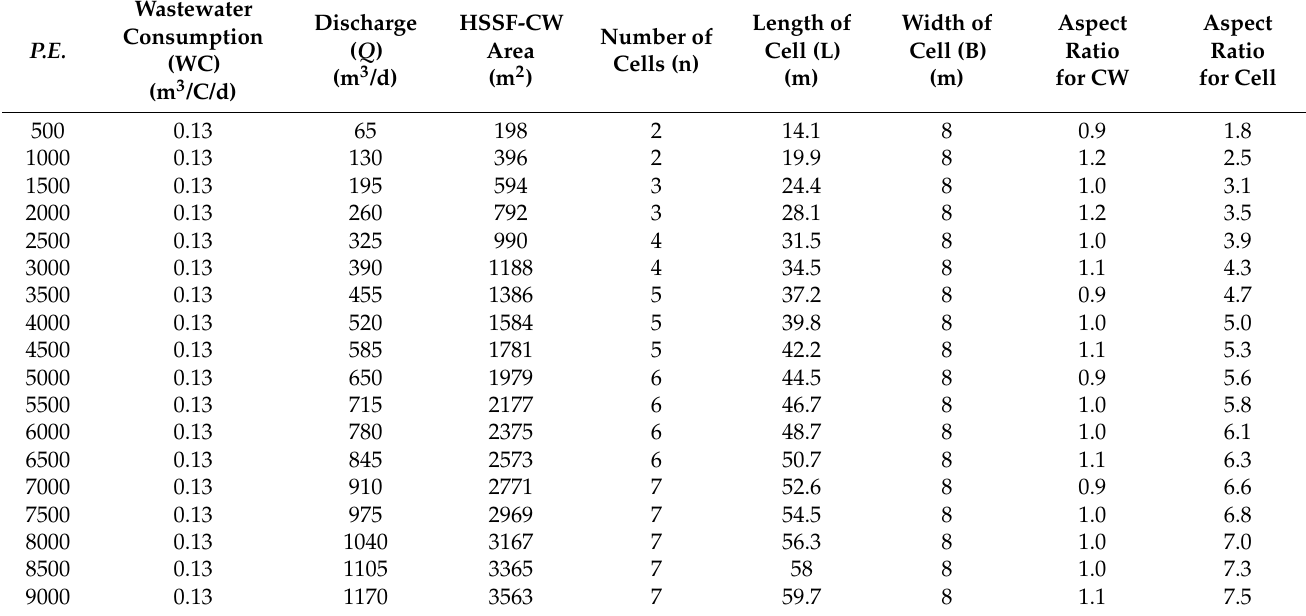
Figure 5. Detailed drawings of HSSF-CW and VF-CW: ( A ) cross-section elevation and ( B ) plan.